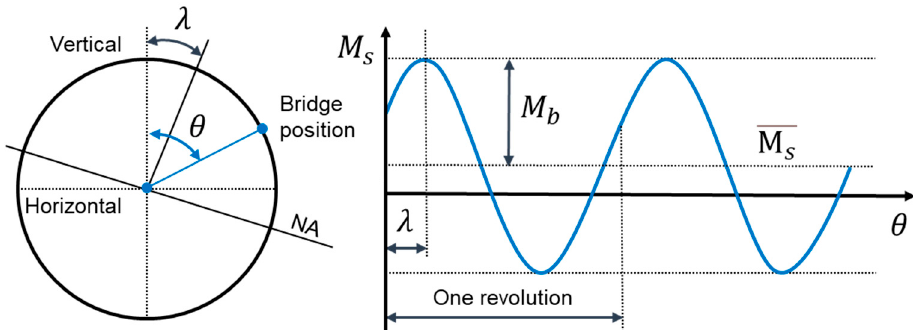
Figure 3. Local bending moment measured at every rotating angle position of strain gauge.